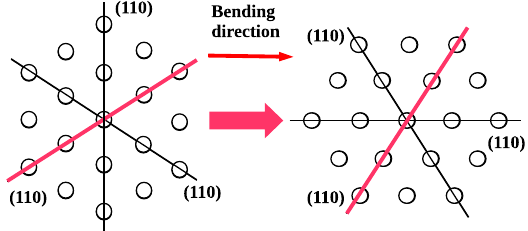
FIG. 9. Rotation of crystal lattice for application of channeling in skew planes. In both case crystal is bent horizontally. Red line indicates the plane (110) used for